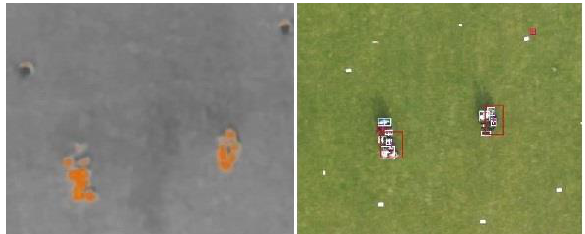
Figure 13. Cropped thermal video frame on the left and the same frame during the processing on the right. The red bounding boxes show detected heat signatures; the white show